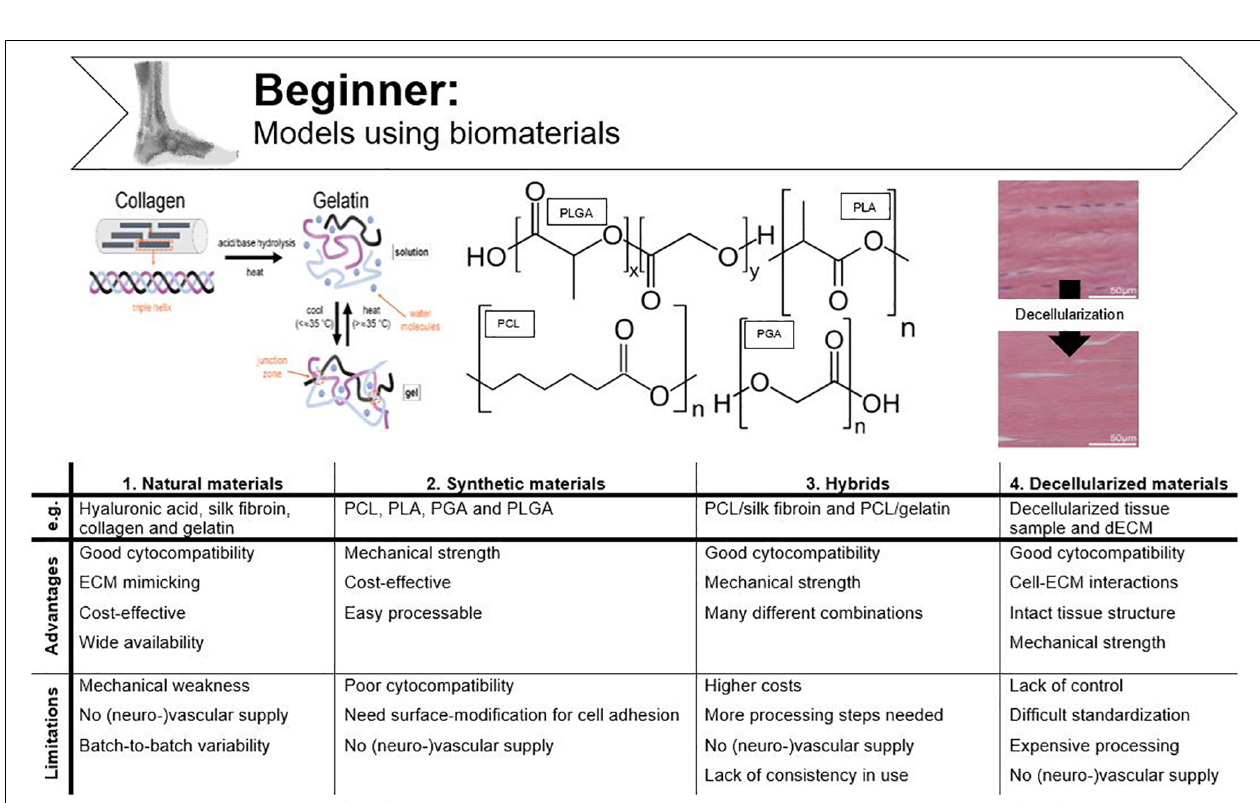
FIGURE 4 | Advantages and disadvantages of tendinopathy models incorporating biomaterials. Adjusted from Barrett et al. (2013) and ChemBAM (n.d.).